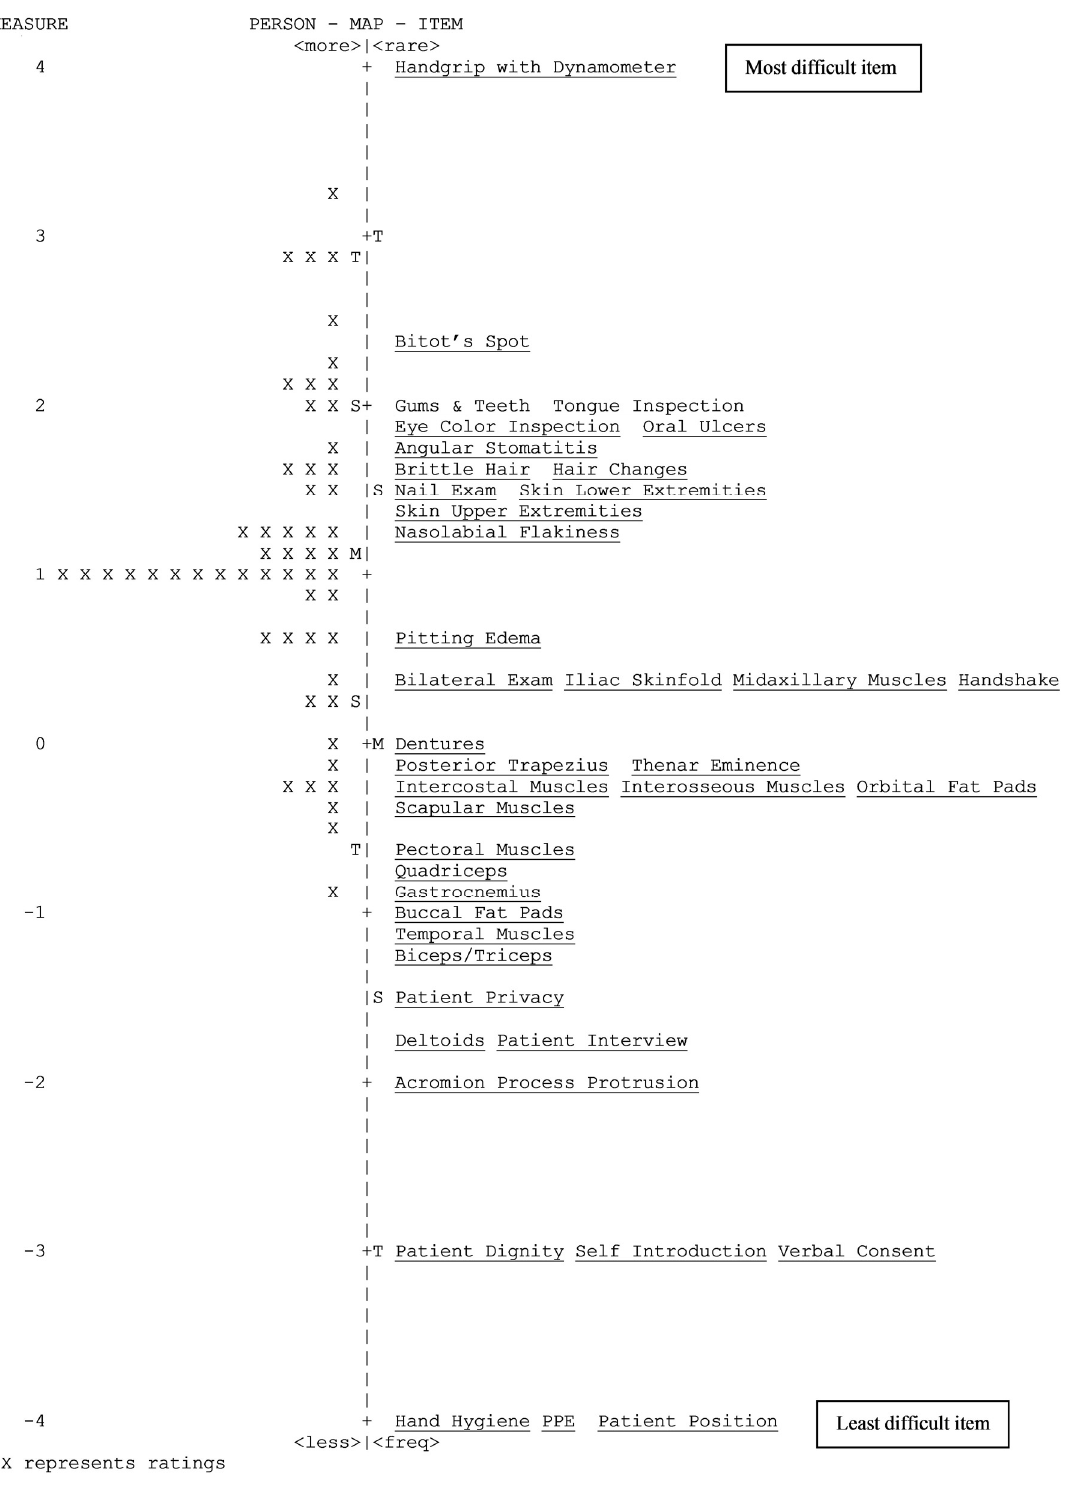
Figure 1. Map of Person Ability and Item